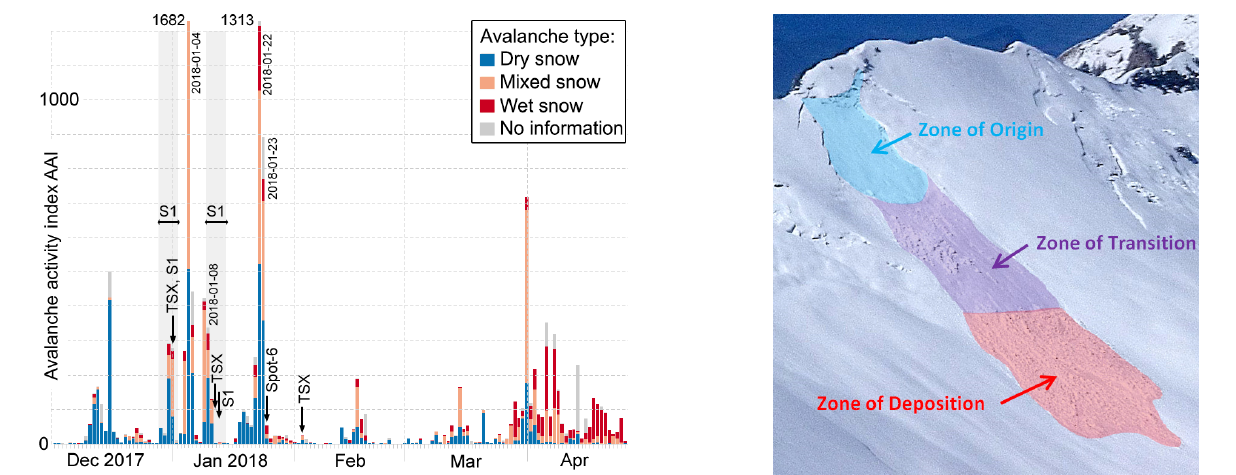
Figure 3. Different avalanche zones illustrated by a slab